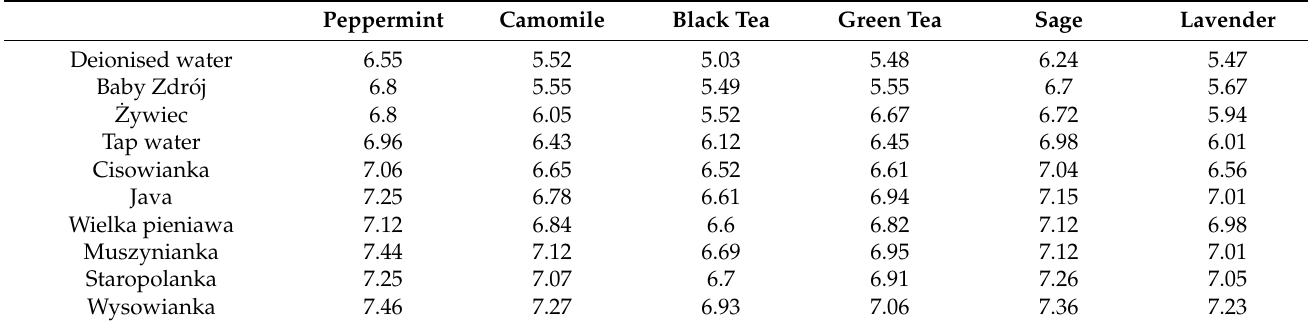
Table 6. pH values of the herbal infusions prepared with the water used in the experiment. Peppermint Camomile Black Tea Green Tea Sage